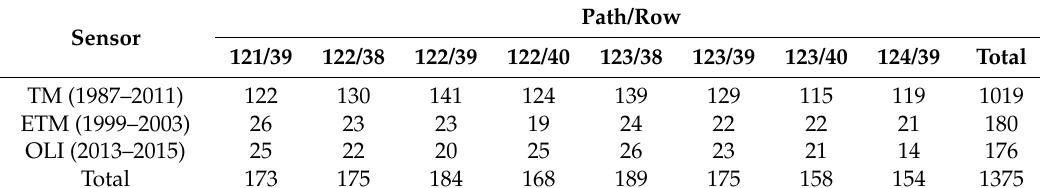
Table 1. Number of Landsat TM, ETM, and OLI scenes processed per path/row.